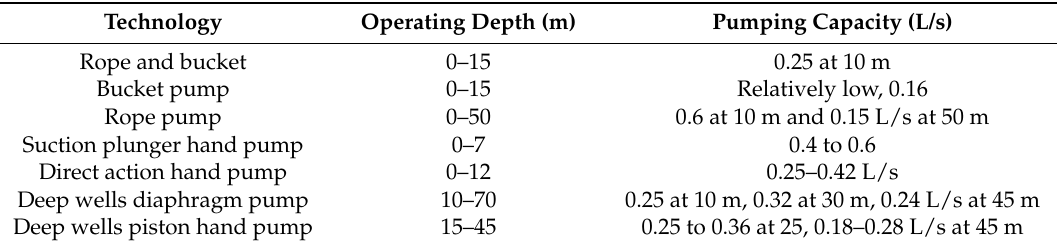
Table 2. Suitability ranges for water-lifting technologies based on Brikk é and Bredero